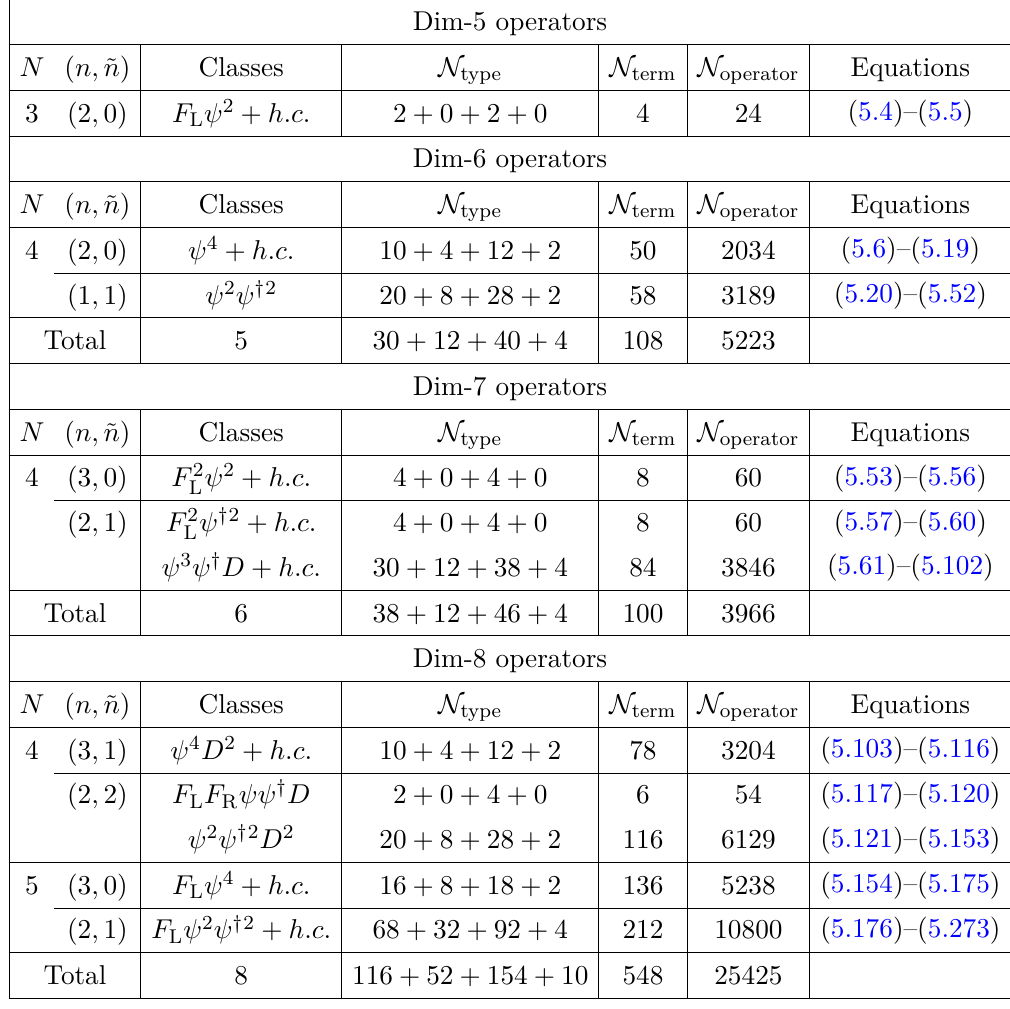
Table 6 . The complete statistics of dimension 5, 6, 7, 8 ν LEFT operators. N in the leftmost column shows the number of particles. ( n, ˜ n ) are the numbers of (cid:15) and ˜ (cid:15) in the Lorentz structure. N type , N term , and N operator show the number of types, terms and Hermitian operators respectively (independent conjugates are counted), while the numbers under N describe the sum of each type possible | ∆ L | types/operators with N = N ( | ∆ L | = 0)+ N ( | ∆ L | = 1)+ N ( | ∆ L | = 2)+ N ( | ∆ L | = 4)